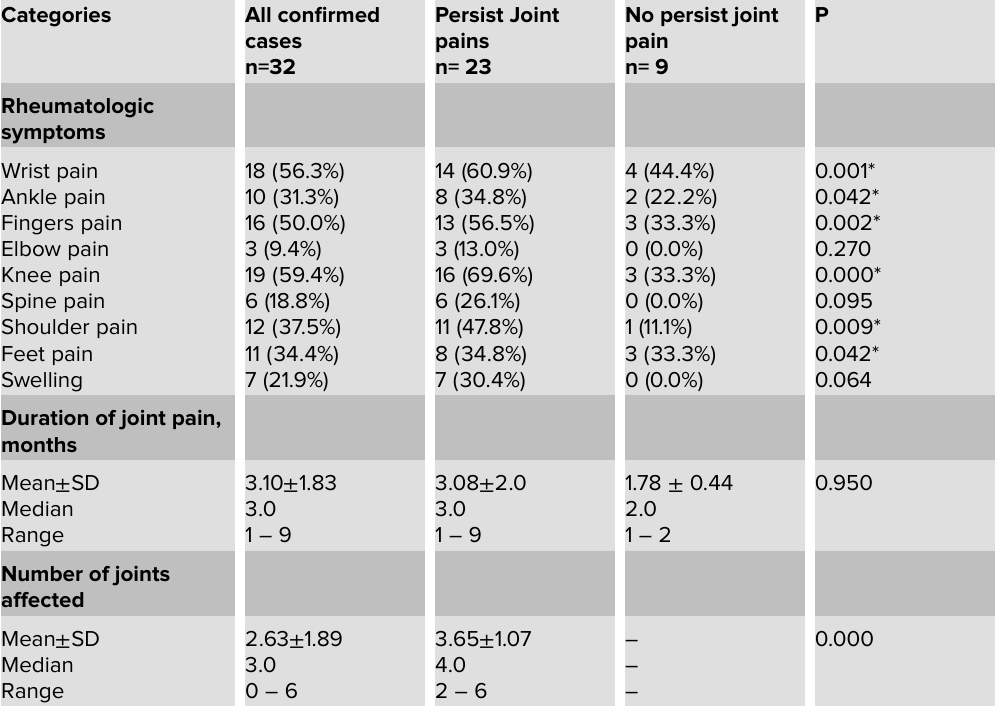
TABLE 2: Symptoms of patients serologically confirmed CHIKV classified according to joint pain status